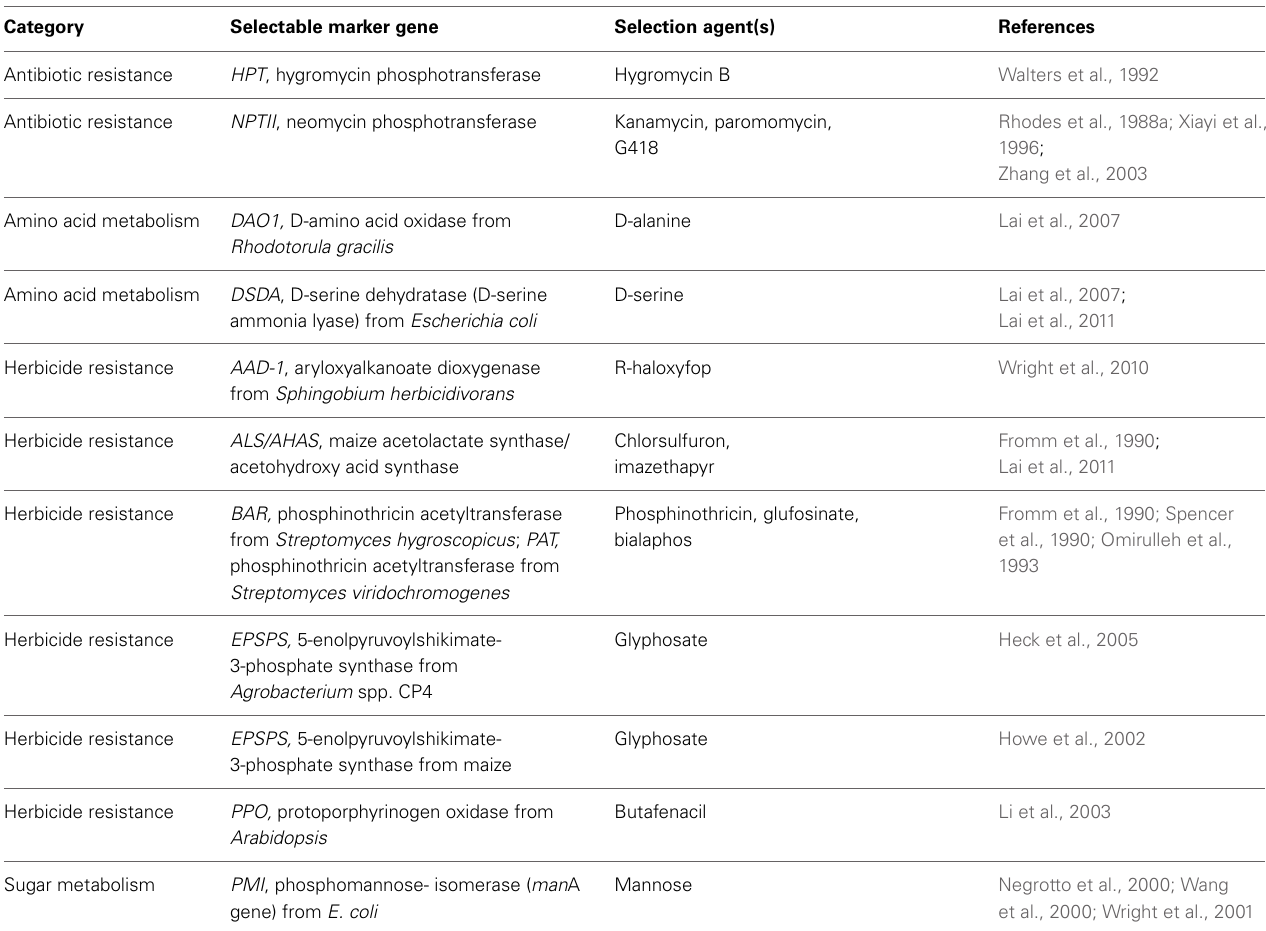
Table 2 | Selection system for generating maize transgenic events.